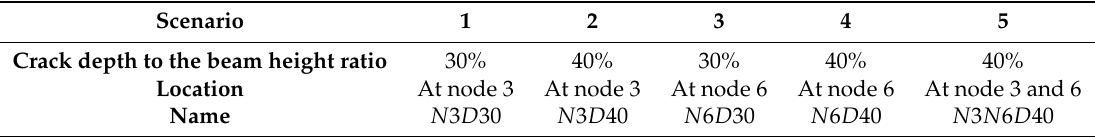
Figure 5. Schematic location of nodes to obtain acceleration data. Table 4. Five damage scenarios considered in the numerical model of the simply supported